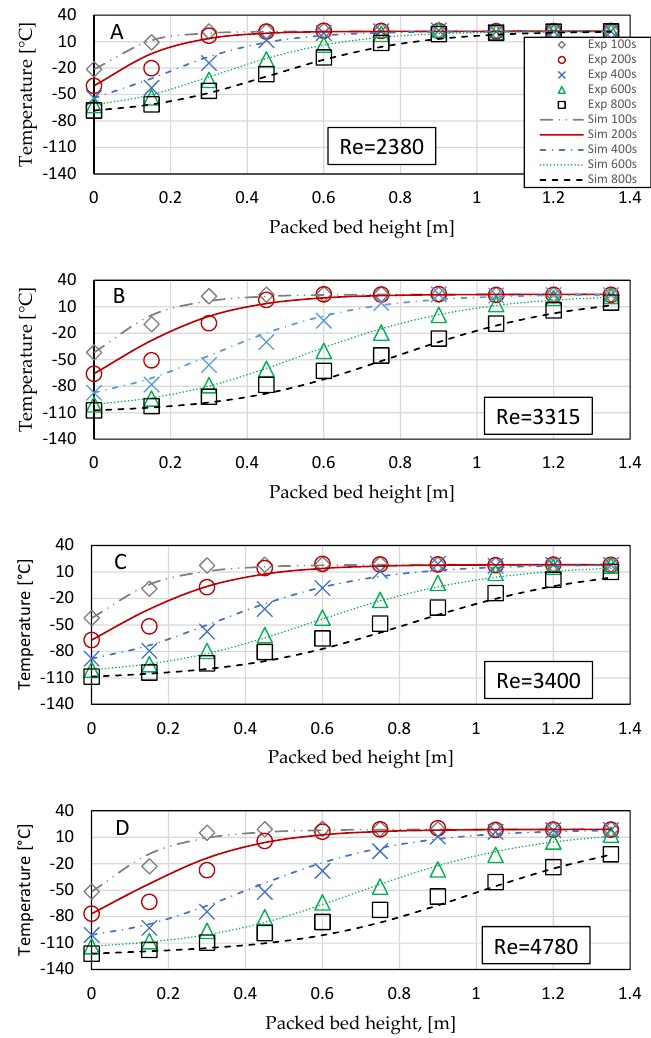
Figure 7. Experimental and predicted temperature front comparisons at different Reynolds numbers. Re = 2387, Re = 3315, Re = 3400 and Re = 4700. Packed bed filled with 10 mm quartzite gravel.